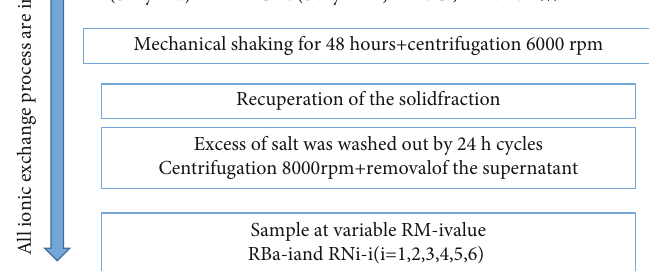
Figure 1: Experimental protocol for the exchange process with the variable solid/liquid ratio. M: Ba 2+ or Ni 2+